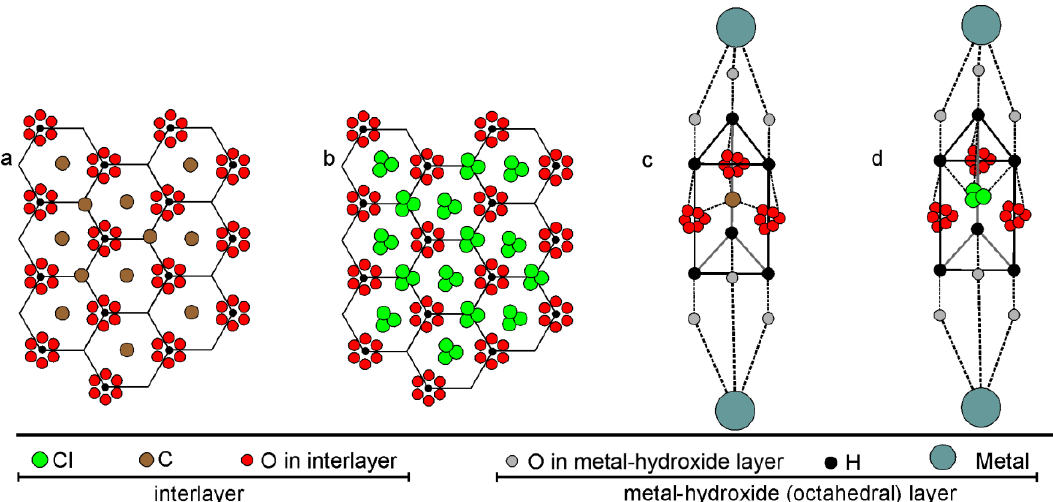
Figure 7. In-plane distribution of water molecules and interlayer species for: ( a ) carbonate and ( b ) chloride members, in accord with an earlier study [31,32,37,38], and the connection of water molecules and interlayer species along the stacking axis for ( c ) carbonate and ( d ) chloride members.